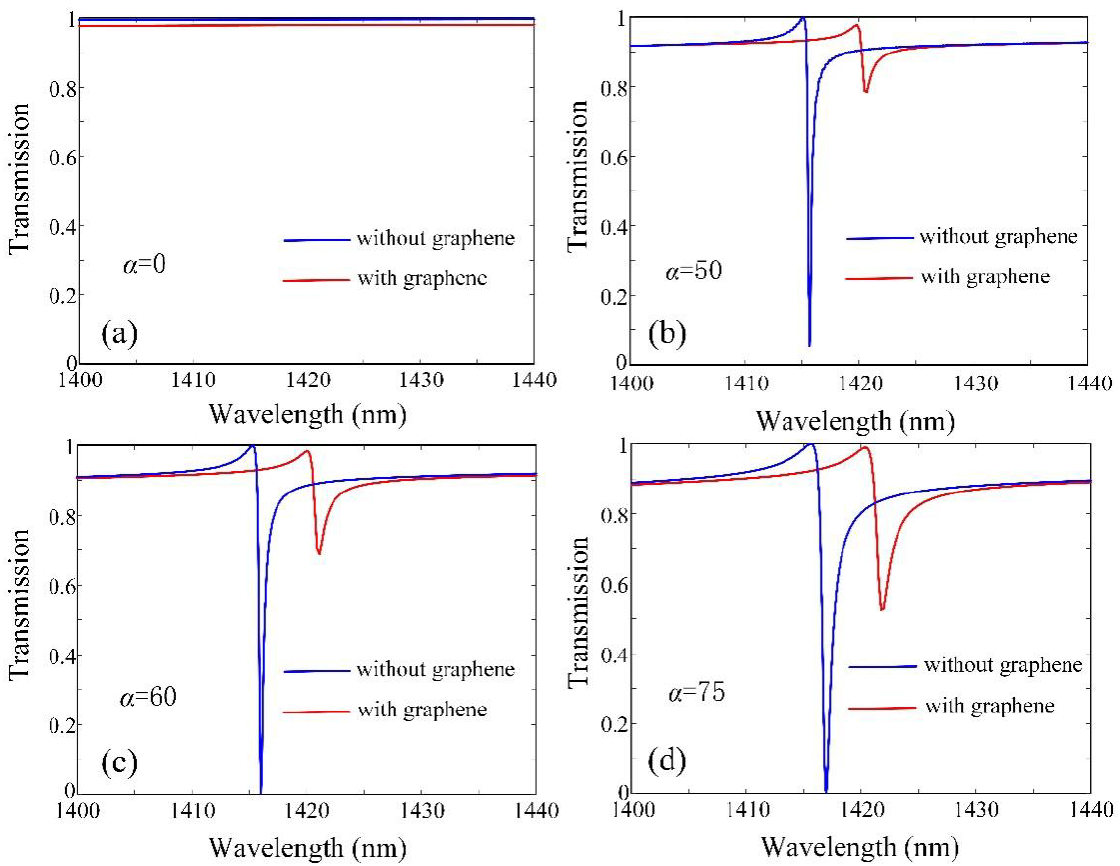
Figure 6. Comparison of the transmission without and with graphene ( E F = 0.5 eV) based on the different ( a ) α = 0, ( b ) α = 50, ( c ) α = 60, ( d ) α = 75 .